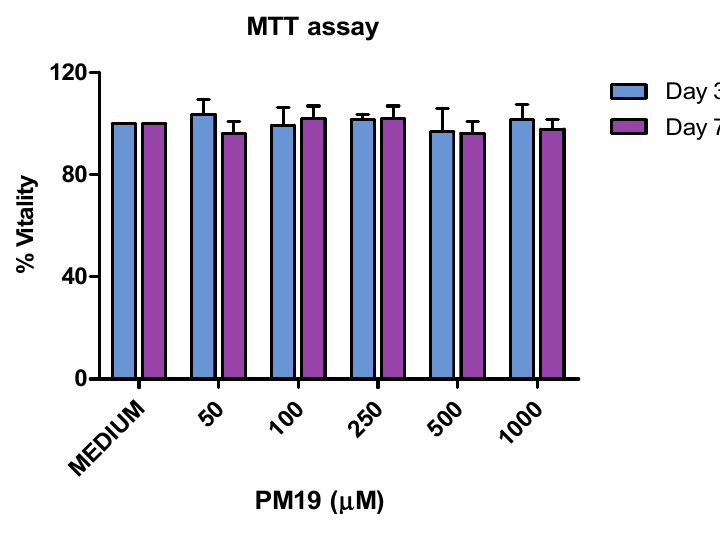
Figure 3. Evaluation of PM 19 toxicity towards cervical tissue (MTT assay). Experiments were performed on endocervical explants from 3 separate donors. Viability is expressed as percentage of untreated controls. Data represent the mean ± SD. MTT